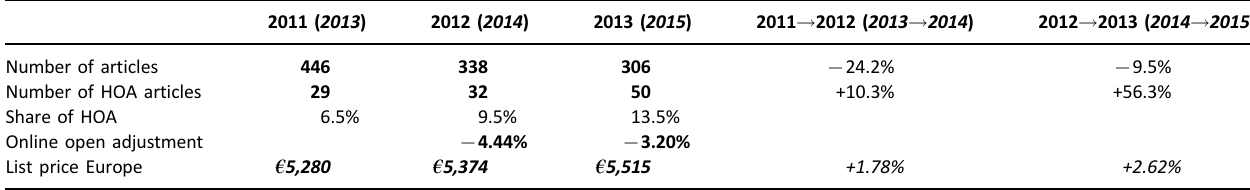
The bold values came from Wiley, http://media.wiley.com/assets/7262/64/Onlineopenadjustments.xlsx and http://wileyonlinelibrary.com/ journals-prices (accessed 17 January 2015). The relevant lists for previous years are no longer available online but the author has a copy; the other were calculated by the